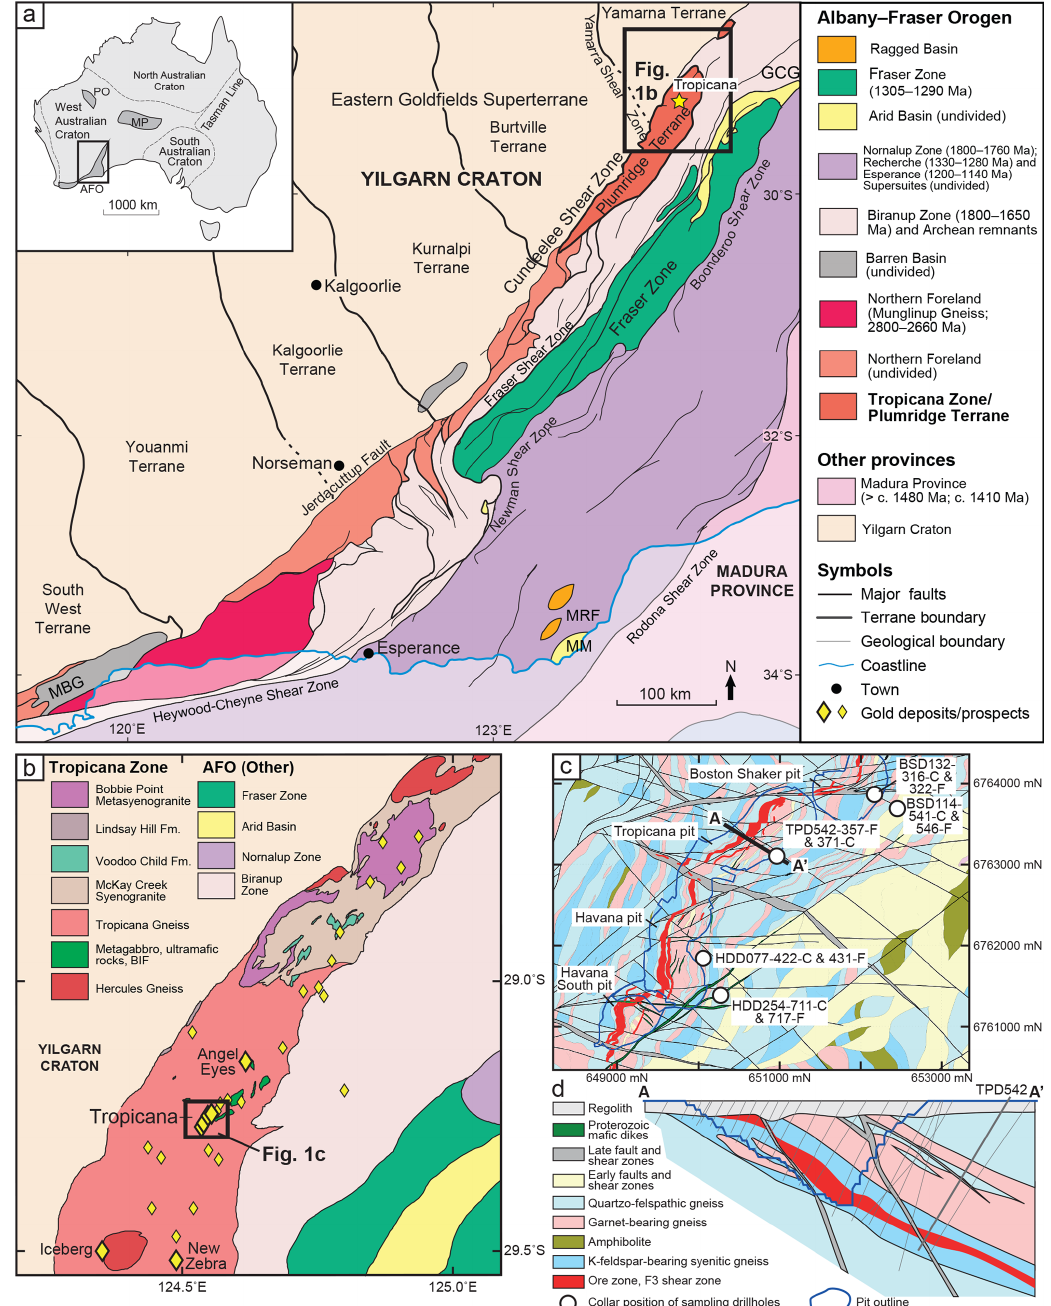
Figure 1. (a) Simplified, pre-Mesozoic interpreted bedrock geology of the Albany–Fraser Orogen, modified from Spaggiari et al. (2015), Doyle et al. (2015) and Scibiorski et al. (2016). The abbreviations used in the figure are as follows: GCG – Gwynne Creek Gneiss, MBG – Mount Barren Group, MM – Malcolm Metamorphics and MRF – Mount Ragged Formation. (b) Interpreted basement map of the Tropicana Zone/Plumridge Terrane, modified from Kirkland et al. (2015). Gold deposits and prospects are shown from the Geological Survey of Western Australia MINEDEX database, with the studied locations labeled. (c) Interpreted basement map of the Tropicana gold mine from internal AngloGold Ashanti maps, showing the locations of the drill holes analyzed in this study. Note that the Tropicana and Havana pits have now joined. (d) Interpreted cross section across the ore-bearing and F3 shear zone of the Tropicana gold mine from AngloGold Ashanti, showing the locations of the drill holes (pale gray lines). All maps use GDA 1994 geodetic datum with (c) using the MGA zone 51